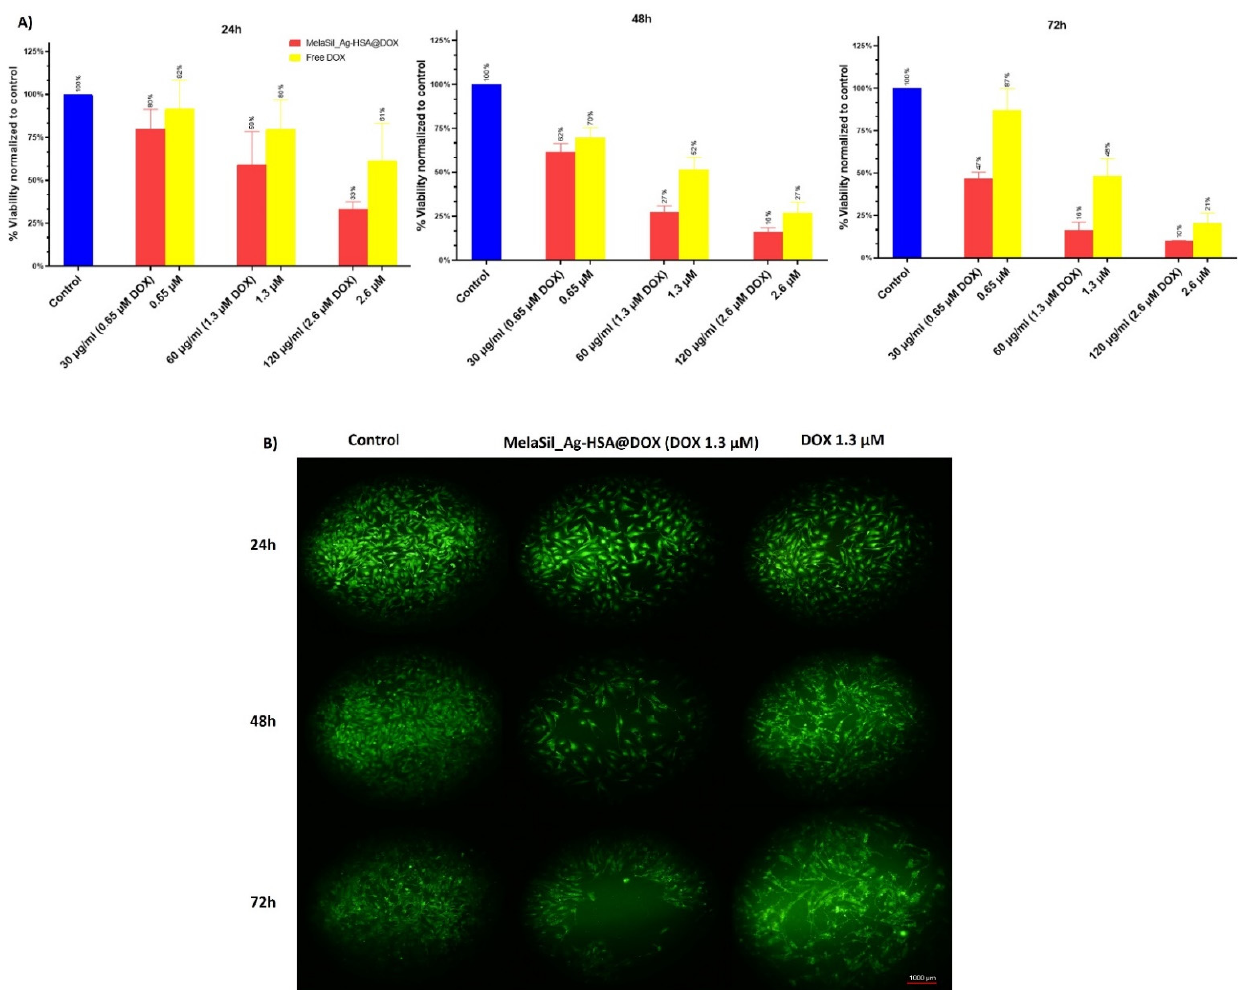
Figure 5. Cell viability assay. ( A ) CellTiter GLO assay of HS578T cells treated for 24 h, 48 h, and 72 h with MelaSil_Ag- HSA@DOX NPs (30, 60 and 120 µg/mL corresponded to DOX 0.65 µM, 1.3 µM, and 2.6 µM) and free DOX (at the same concentrations). p < 0.05; ( B ) Representative images of Calcein-AM fluorescent morphology images of HS578T cells before and after treatment with MelaSil_Ag-HSA@DOX NPs and free DOX. Scale bar 1000 µm.